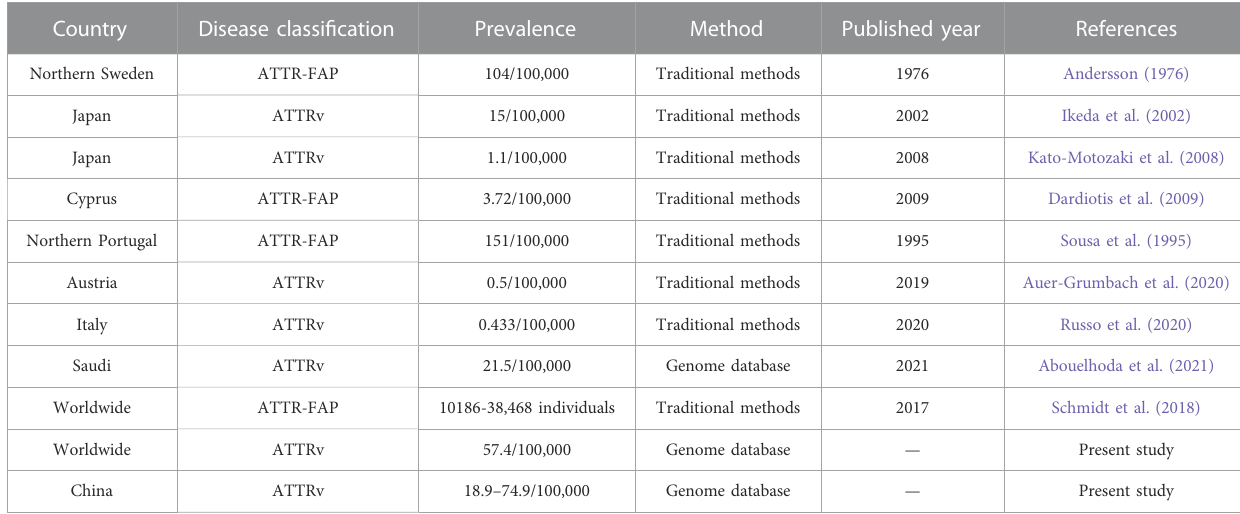
TABLE 3 Previous ATTRv prevalence